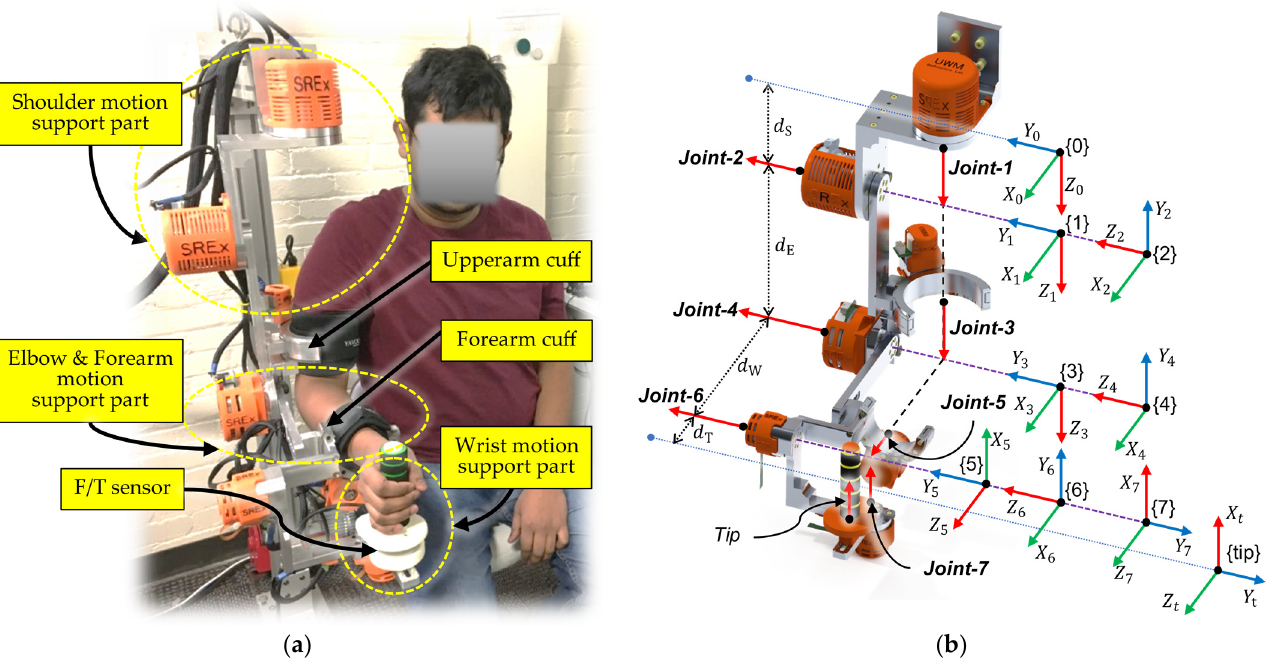
Figure 1. ( a ) Smart robotic exoskeleton ( SREx ); ( b ) SREx ’s link-frame assignment, which represents the axes of rotation.